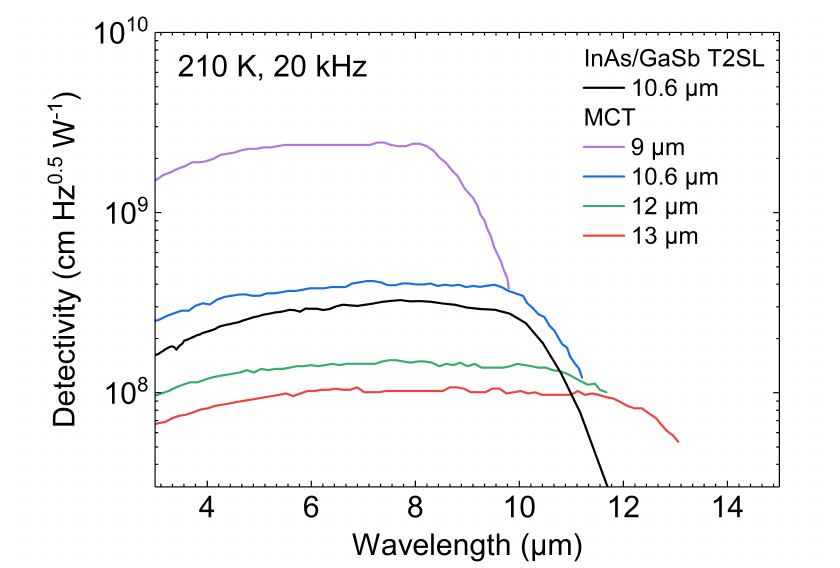
Figure 3. Detectivity of InAs / GaSb T2SL photoconductors (mean value) and commercial mercury cadmium telluride (MCT) photoconductors from VIGO System (guaranteed values) for di ff erent cuto ff wavelengths at 210 K and 20 kHz